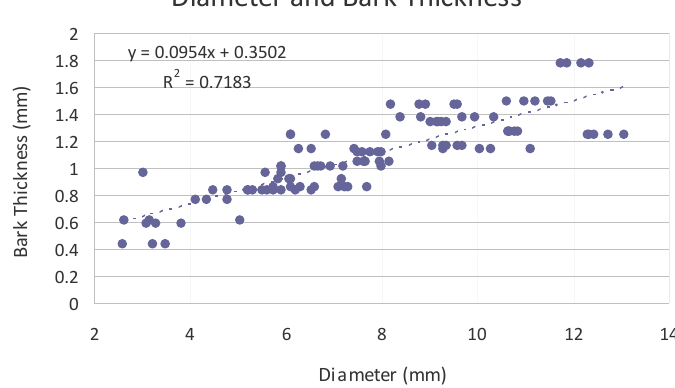
Figure 18. Correlation analysis between the diameter of the cotton plant’s main stalk to the bark thickness.